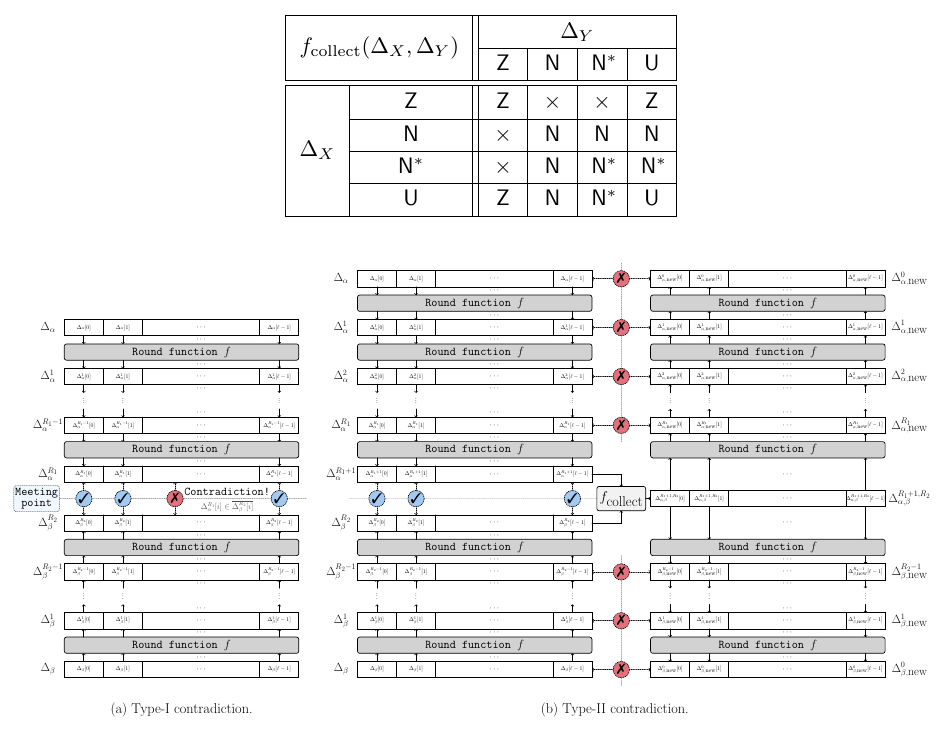
Figure 4: Different categories of